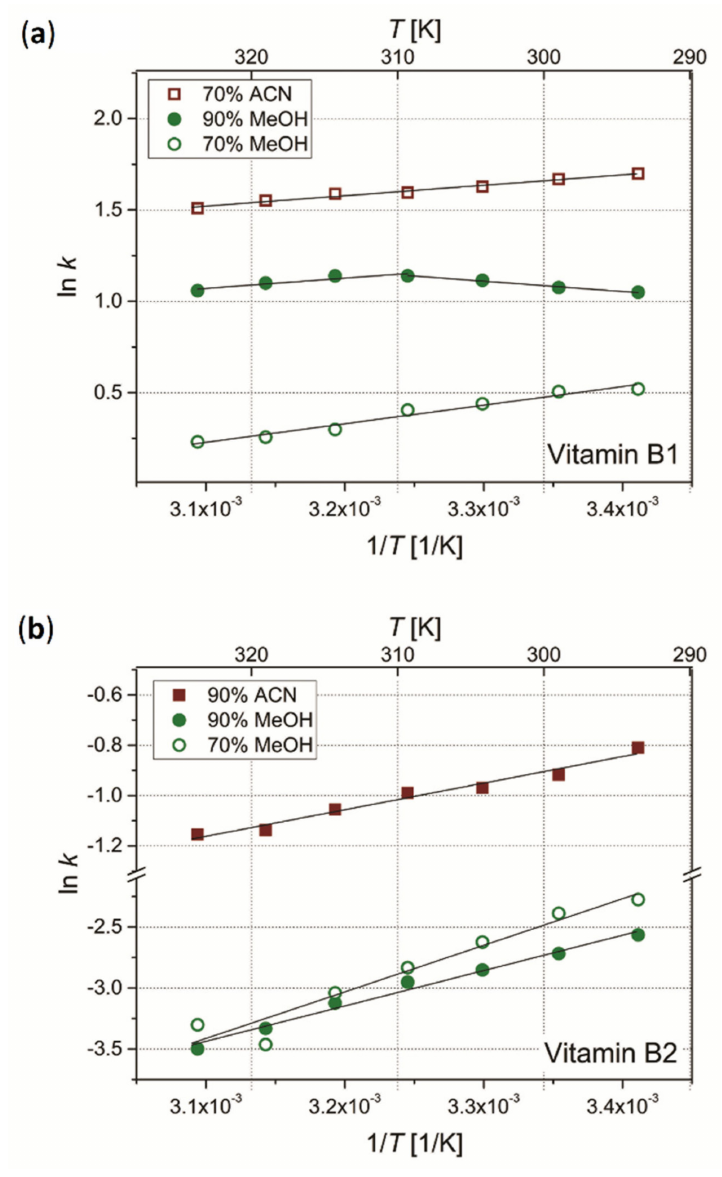
Figure 4. Effect of temperature on retention coefficient of: ( a ) vitamin B1 and ( b ) vitamin B2 in column A (Acclaim™ Mixed–Mode HILIC